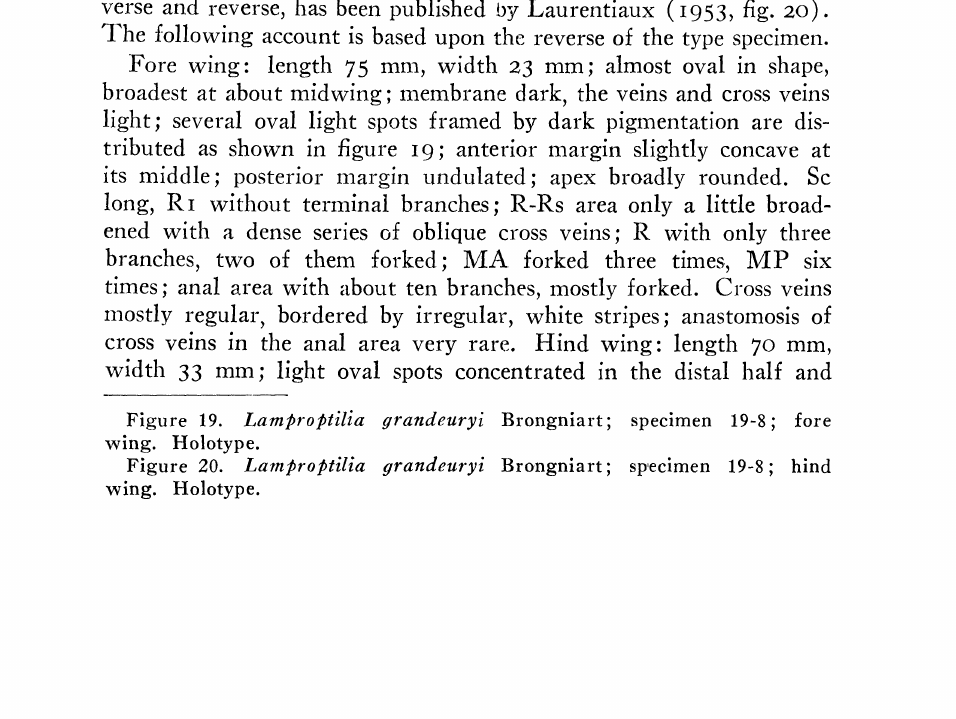
Figure 20. Lamproptilia grandeuryi Brongniart; specimen 19-8; hind wing.